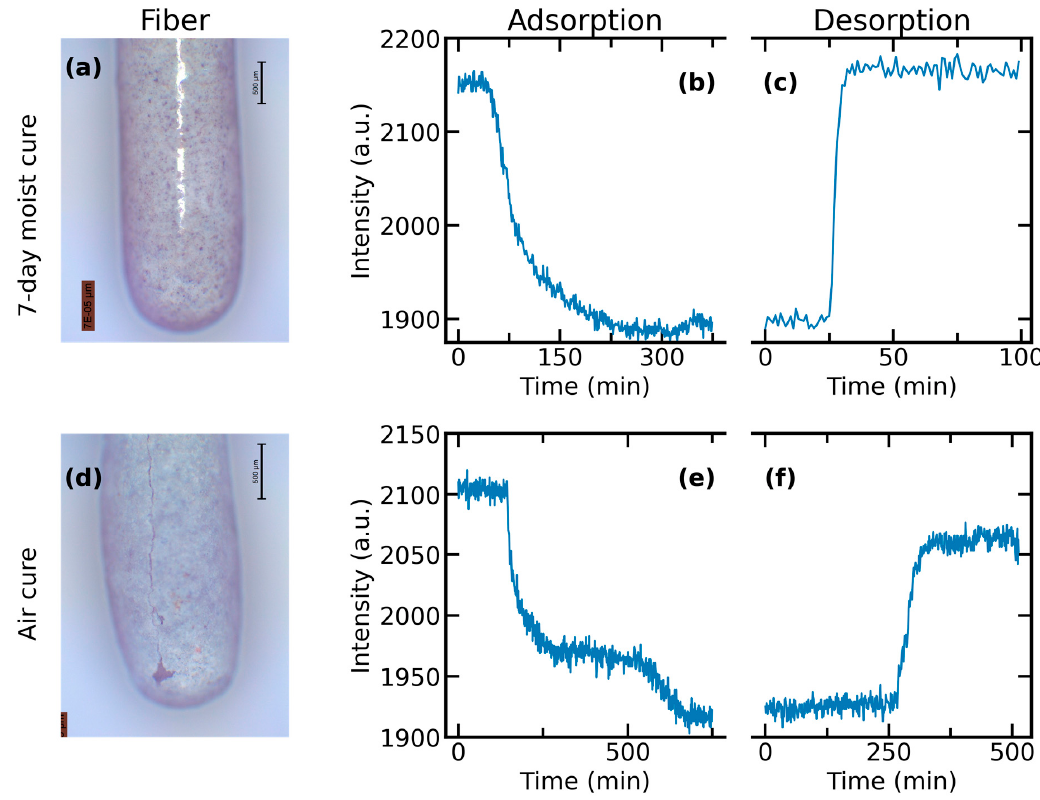
Figure 4. ( a ) Image of the seven-day moist cured cement paste around the multimode optical fiber. ( b , c ) are the adsorption and desorption between 100% RH and ambient RH for the seven-day moist cured cement paste. ( d ) Image of a cement paste sample left to cure in air, displaying large cracks. ( e , f ) are the adsorption and desorption branches between 100% RH and ambient RH for the air-cured cement paste.